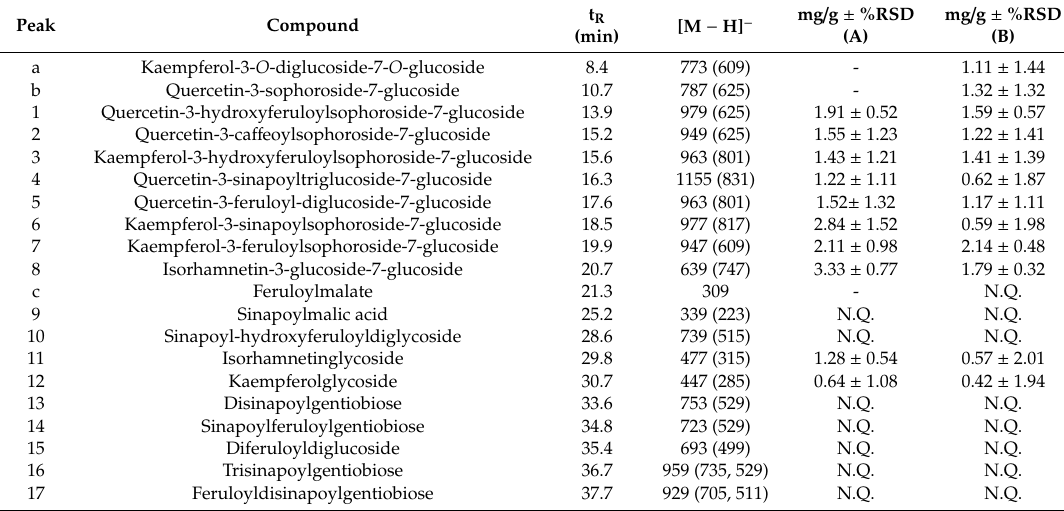
Table 1. Polyphenolic determination of B. incana leaf (A) and flowering top (B) hydroalcoholic extracts by LC-PDA-MS /